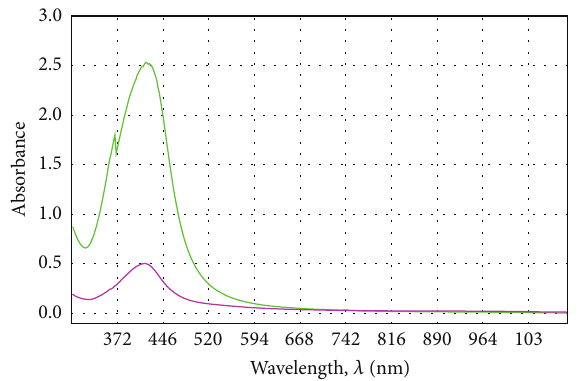
Figure 7: Chart of average clusters containing NAg suspensions spectrum.